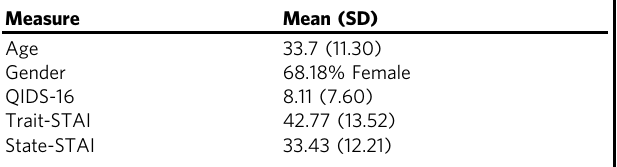
QIDS-16; Quick Inventory of Depressive Symptoms, 16 item self-report version. Trait/State- STAI; Speilberger State-Trait Anxiety Inventory. Note that scores of 6 or above on the QIDS-16 indicate the presence of mild depressive symptoms. The Trait/State-STAI has no standard cut- off